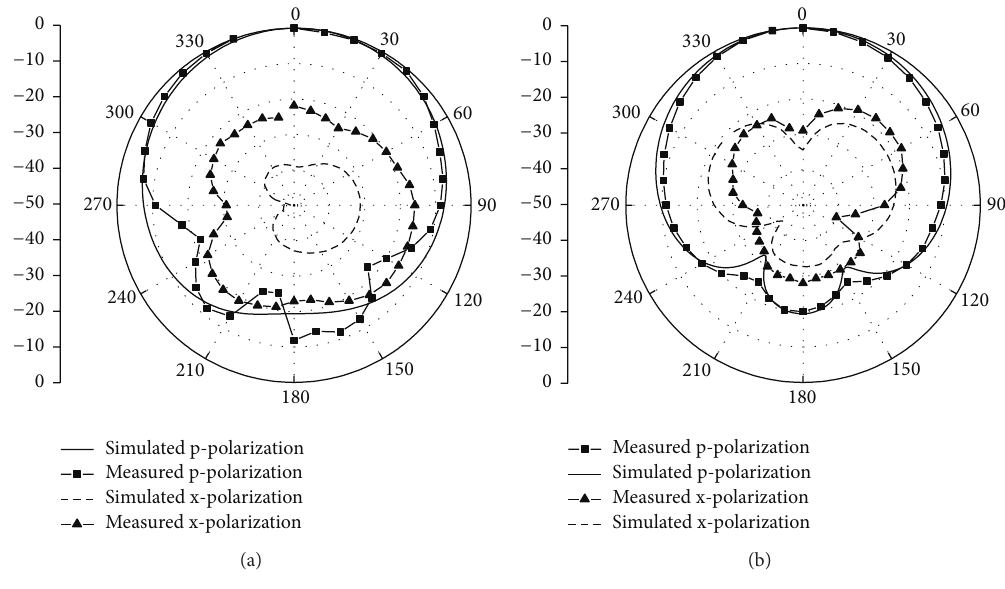
Figure 8: Radiation patterns of port 2: (a) 𝐸 -plane; (b) 𝐻